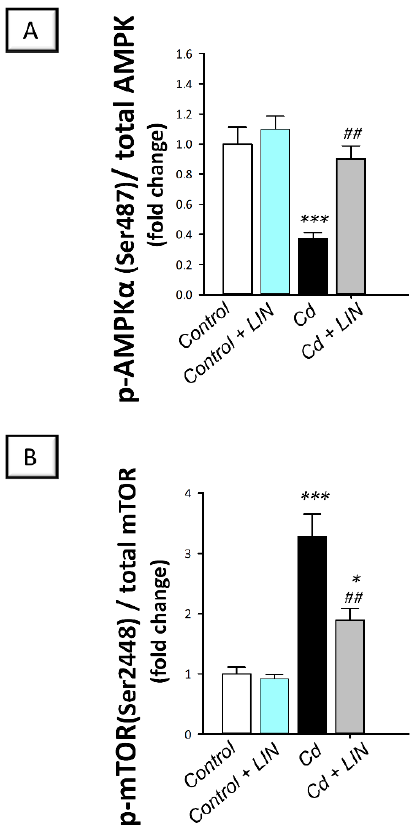
Figure 10. Effect of cadmium and/or linagliptin administration on testicular AMPK/mTOR in rats. The co-treatment with linagliptin stimulated the testicular pro-autophagic AMPK/mTOR pathway that was suppressed by cadmium metal. This was demonstrated by increased phosphorylation of the AMP-activated protein kinase (AMPK; Ser487) to the total AMPK protein ( A ) together with the diminished phosphorylation of the mammalian target of rapamycin mTOR (Ser2448) to the total mTOR protein ( B ). * p < 0.05, and *** p < 0.001 show statistical significance compared to the group of control rats; ## p < 0.01 show statistical significance compared to the group of cadmium-intoxicated rats. Values are stated as the mean ± standard error of the mean for 6 animals per group. LIN, linagliptin; Cd, cadmium chloride.